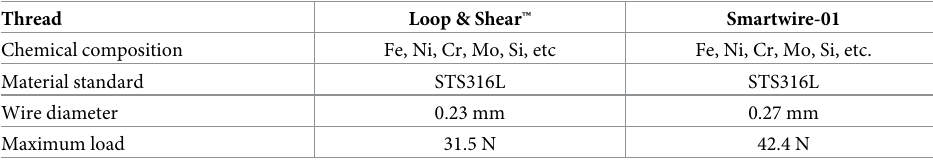
Table 2. General characteristics of